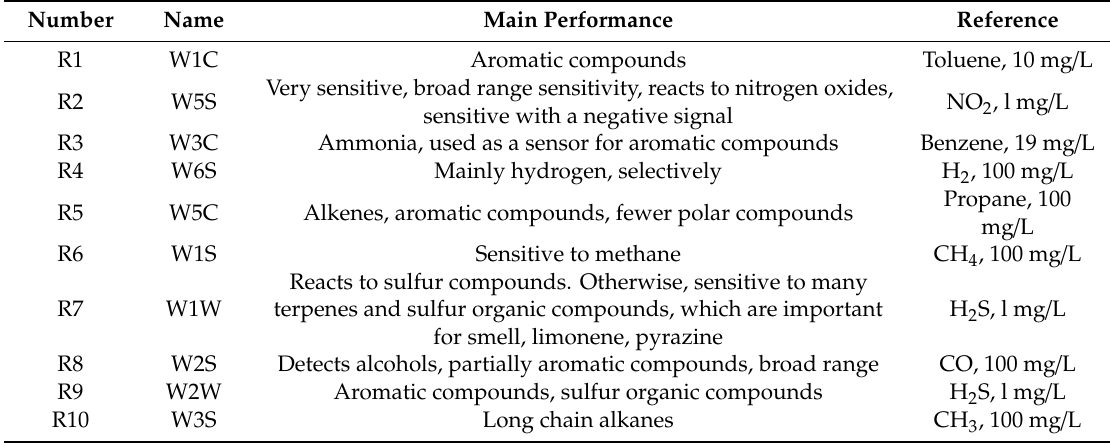
Table 1. Sensors used in PEN